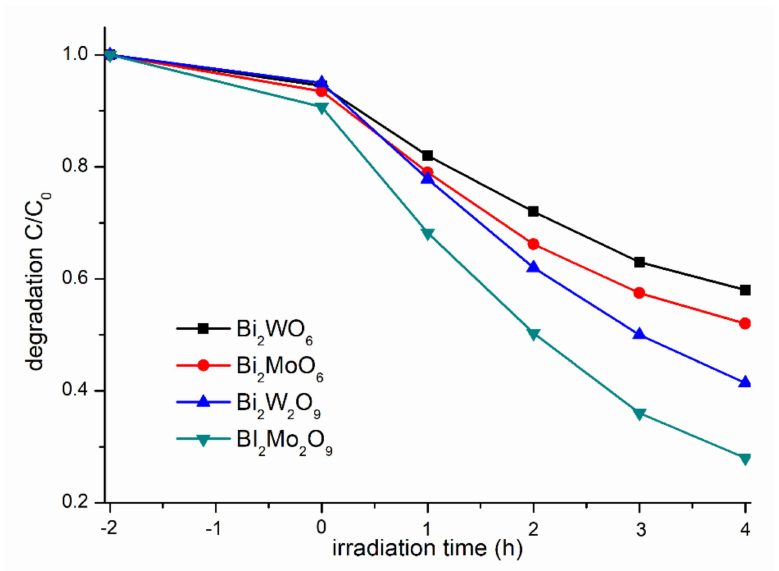
Figure 7. Comparison of absorption and degradation rate of MB using Bi 2 WO 6, Bi 2 W 2 O 9 , Bi 2 MoO 6 and Bi 2 Mo 2 O 9